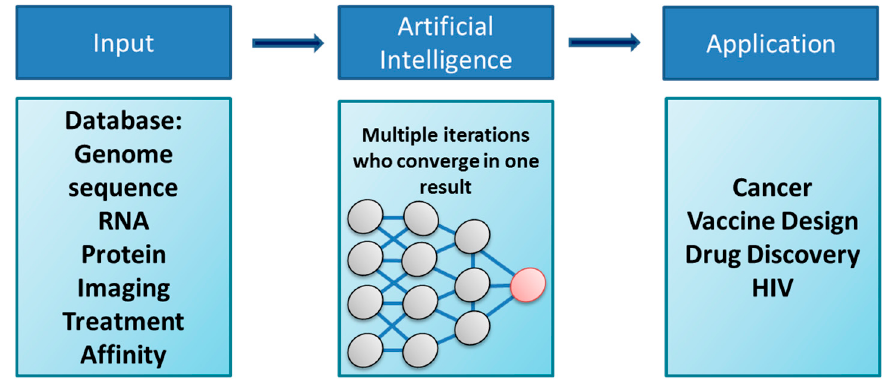
Figure 1. Cartoon denoting the main aspects of deep learning algorithms and artificial intelligence (AI) in biology. As described in the text, critical points include the input information, the features selected for analysis, the training of the AI, the numbers of layers or variables or classifiers, as well as the desired output. The unbiased connection between the different clusters or layers of the AI system will provide the best predictors for associated gene/mRNA/protein for a particular biomarker. If this biomarker is unknown, the clusters can select the dysregulated pathways or better treatments based on the input information. Thus, the possibilities are endless.